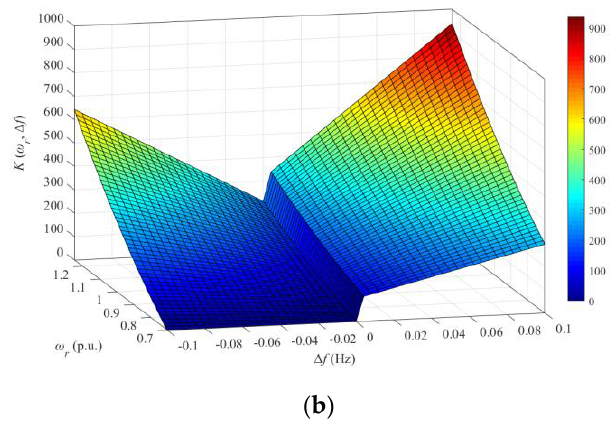
Figure 4. Proposed power-smoothing scheme of a DFIG. ( a ) Proposed power-smoothing scheme; ( b ) K ( ω r , Δ f ) represented in the three-dimensional space used in this paper.